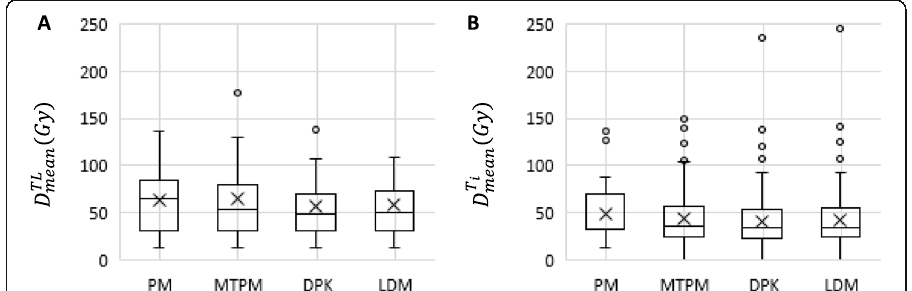
Fig. 6 Mean absorbed doses delivered to the aggregated tumoral liver a and each individual tumor b volumes, determined by means of multicompartmental (PM and MTPM) and 3D voxel dosimetry methods (LDM and